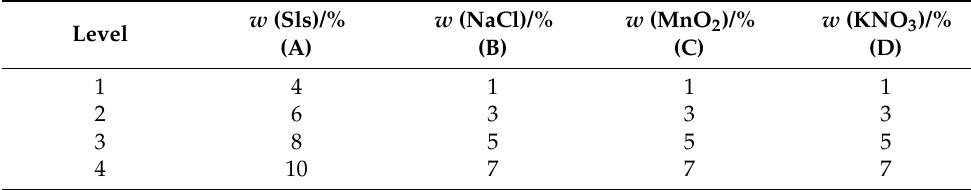
Table 3. Factors and levels of orthogonal